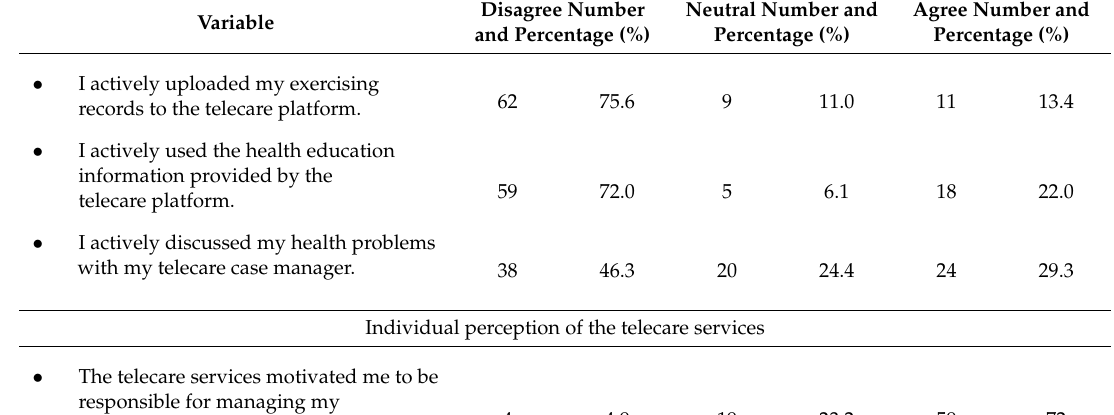
Neutral Number and Percentage (%)